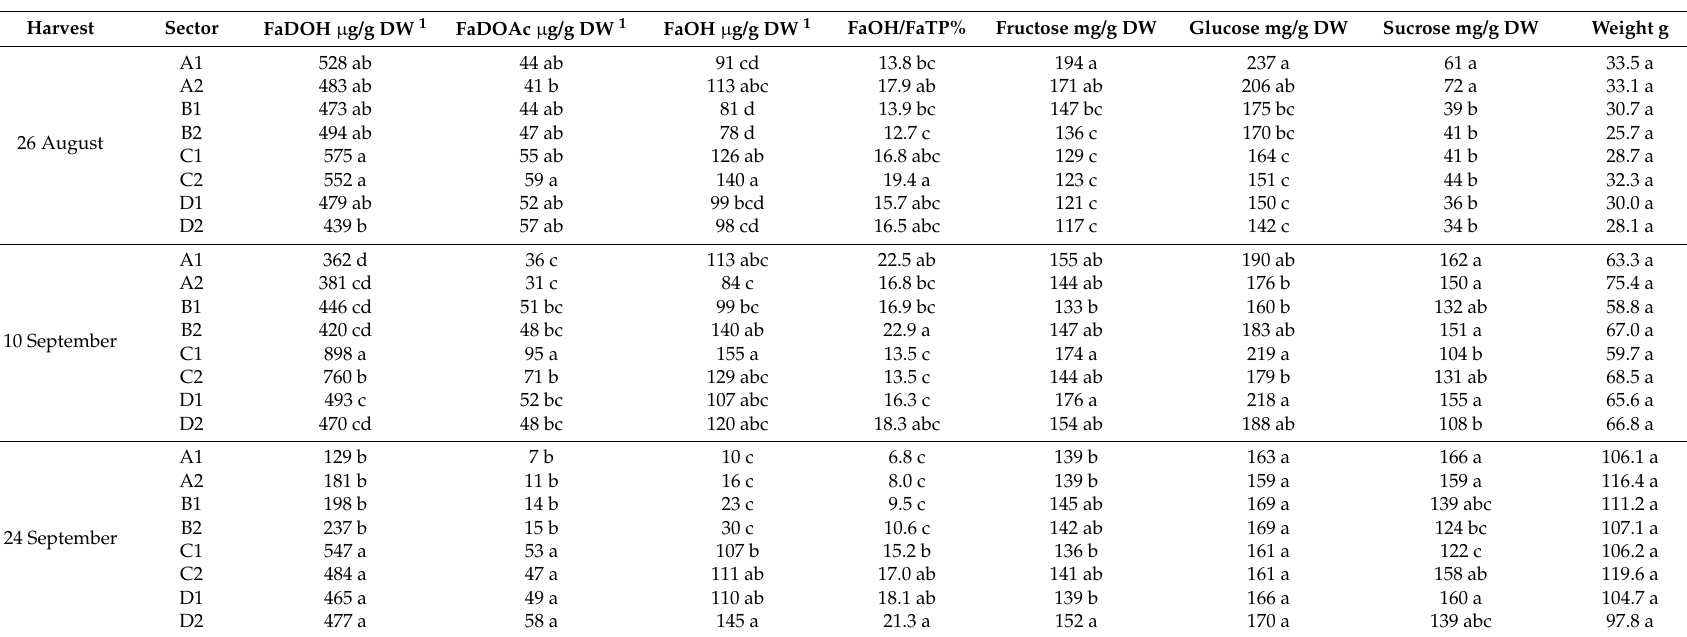
Table 3. Concentrations of FaTP, concentrations of soluble sugars and root weight in carrot samples from different sectors of the field trial at the three harvests in 2006. Means within the same section of a column followed by different letters are significantly different according to one-way ANOVA with Duncan’s post hoc test ( p < 0.05).